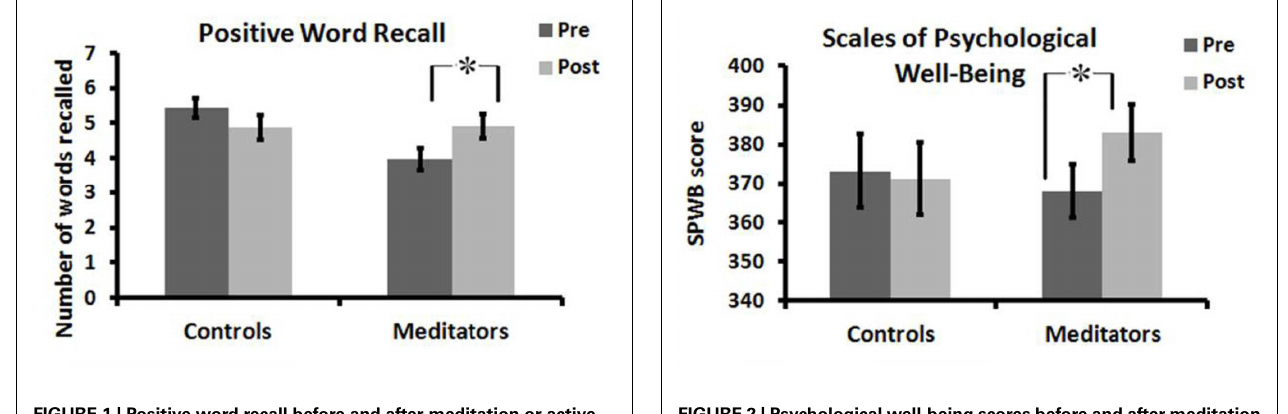
FIGURE 1 | Positive word recall before and after meditation or active control condition, * p < 0.05. Error bars represent SEM.